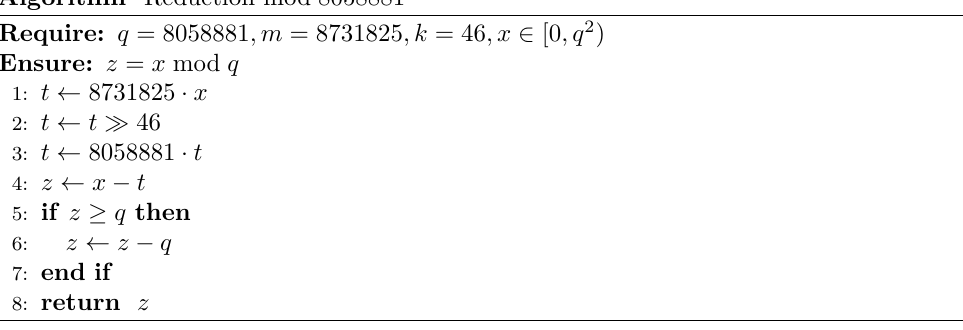
Algorithm Reduction mod 8058881